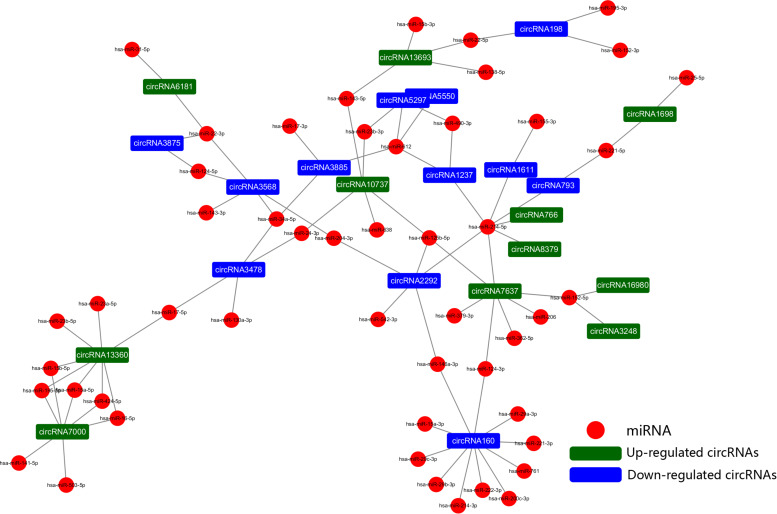
The circRNA-miRNA network. The generated network consists of 73 nodes (23 dysregulated circRNAs and 50 miRNAs) and 83 edges. According to the network, we predicted that 12 down- and 11 upregulated circRNAs have miRNA binding sites and could act as ceRNAs to regulate posttranscriptional gene expression.